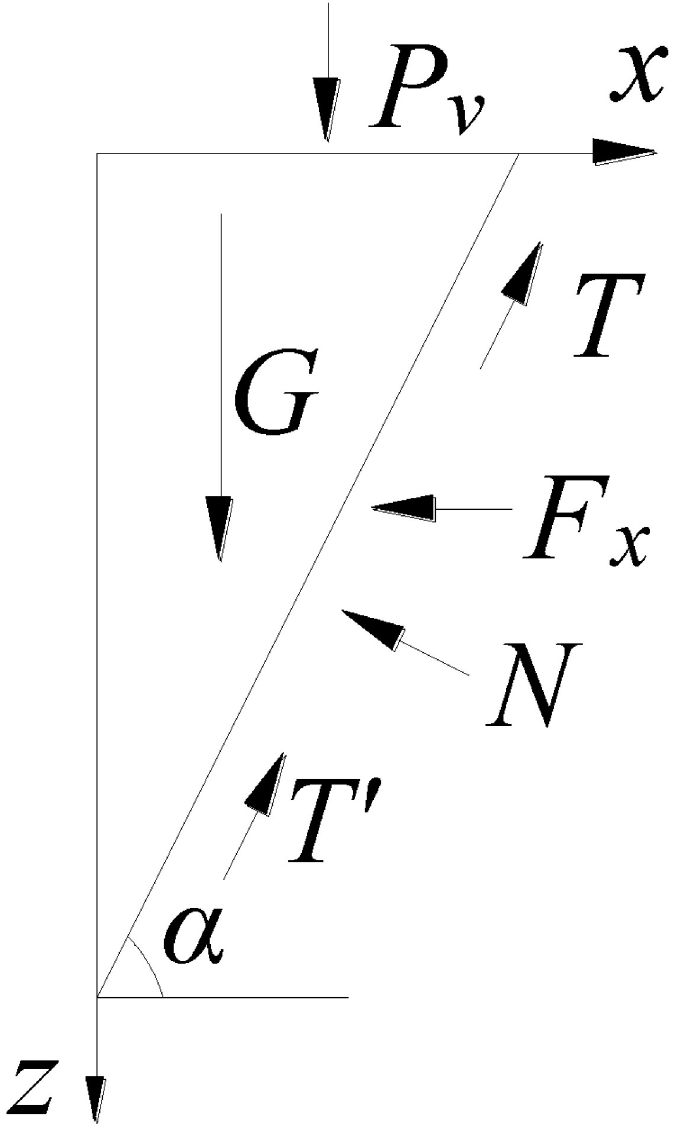
Fig 12. Forces acting upon cone-like sliding body. Symbols: P v = vertical force; F x = horizontal seepage force; G = self-gravity; T = friction at the bottom surface; T ’ = friction at the side surface; N = bottom surface support force; α = angle of inclination of the sliding